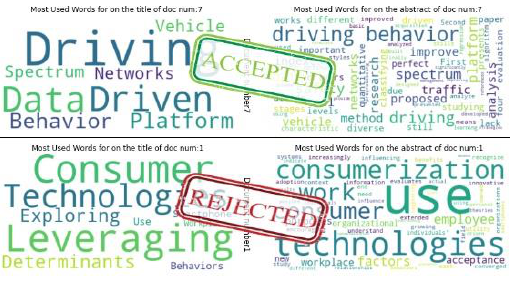
Figure 4. Example of word cloud generated from tow